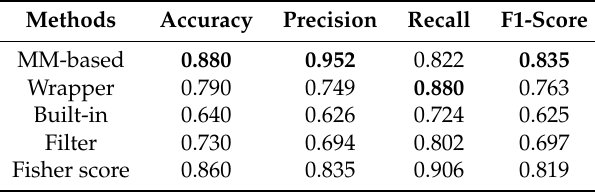
Table 2. Comparison results under the BiLSTM